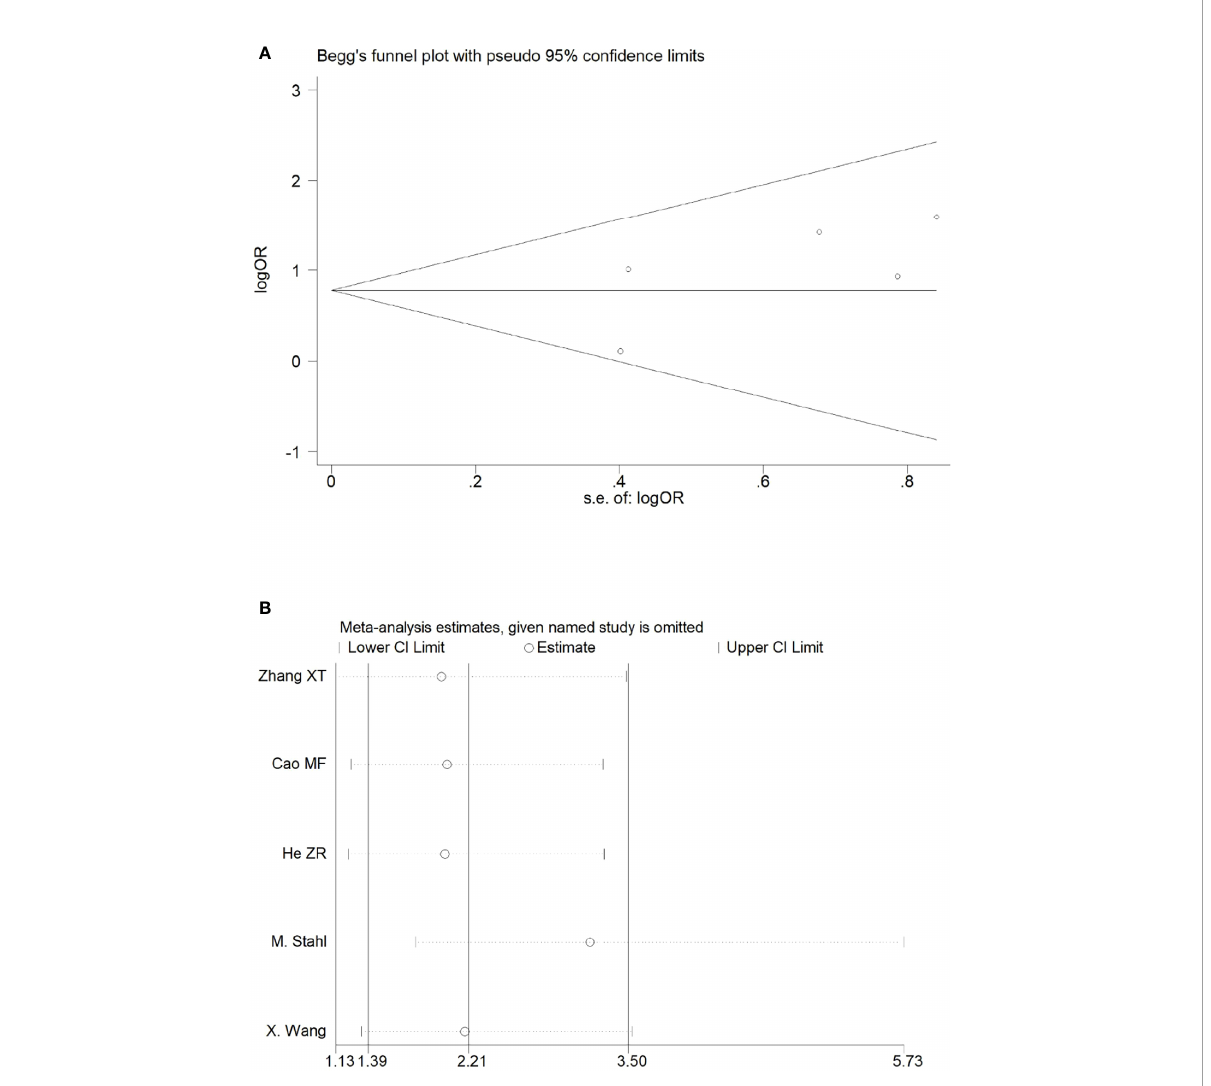
FIGURE 11 Begg ’ s funnel plot (A) and sensitivity analysis (B) of all the included studies for the analysis of the pCR